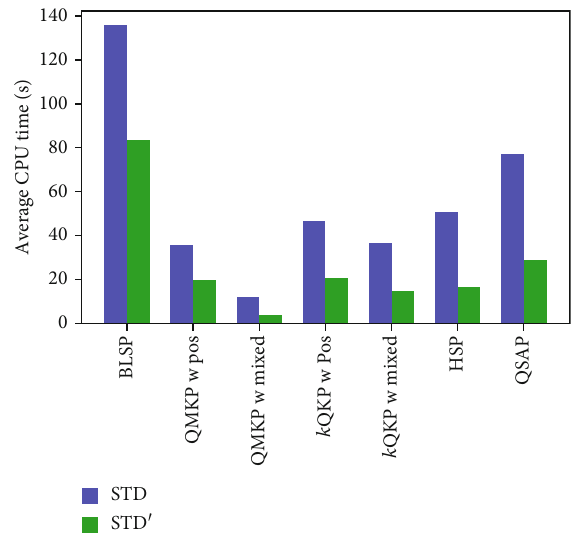
Figure 2: Average CPU times (s) for Question